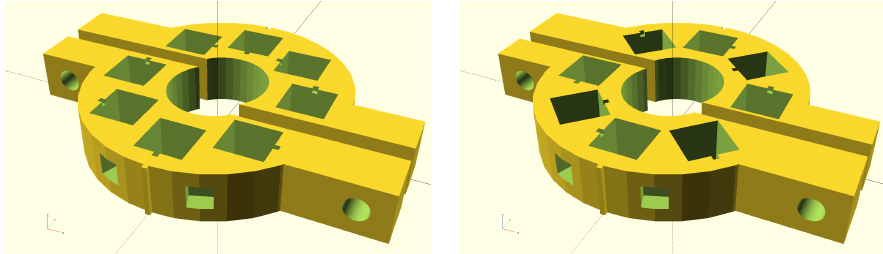
Figure 1. The frames for dipoles ( left ) and quadrupoles ( right